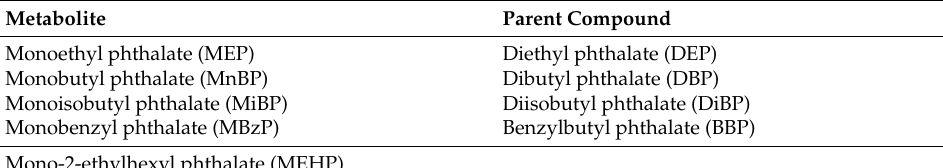
Table 1. Metabolites and the parent compounds